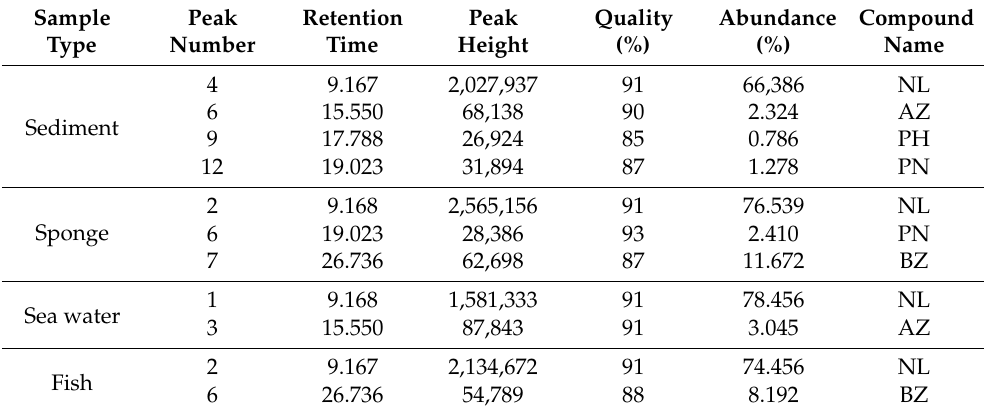
Table 4. Types and abundance of PAH in samples collected from ST 1 based on the GC/MS chro- matogram.